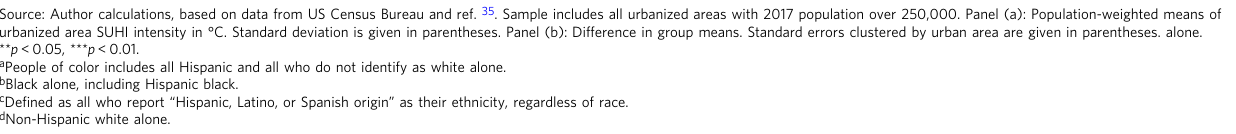
Climate zone Arid Snow Temperate Equatorial